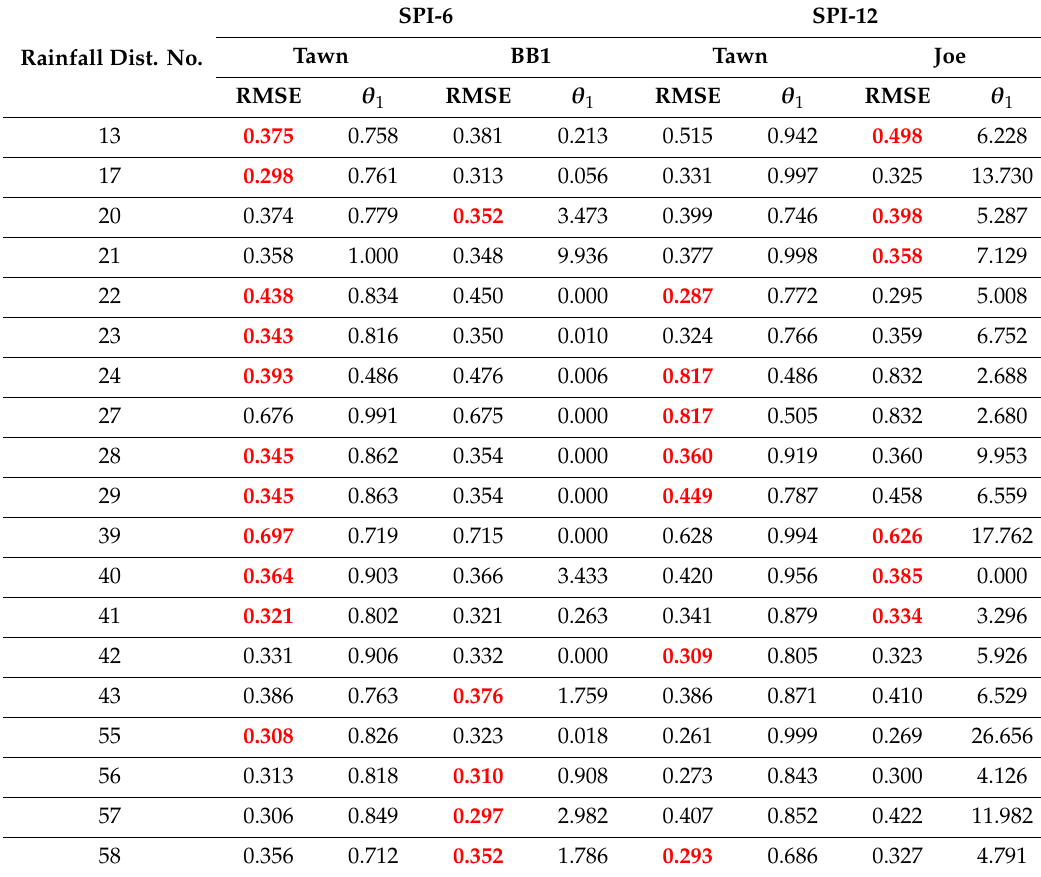
as shown in Figure 8, a consequence of the formulations given in Equations (10) and (11). In terms of drought risk analysis, the study area exhibited a noticeable north-west to south-east gradient with Bu ff alo City, Tambo and Alfred Zoo regions determined to have higher / lower risks in terms of the conjunctive / cooperative multivariate drought risk (copula) probability